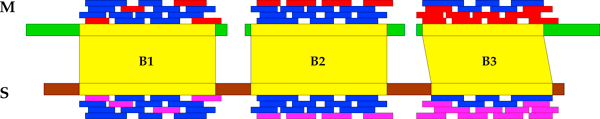
Blocks construction and coverage filtering. Blocks are identified by regions belonging to M and S that share a relatively high amount of mapped reads. In this figure, blue reads identify clusters of adjacent reads that are uniquely mapped in the same contig of both the assemblies. Moreover, GAM-NGS discards blocks like B3 that contains a small amount of shared reads compared to the number of reads aligned in the same regions (e.g., in B3 these are less than 35% and this block may create a wrong link between contigs).